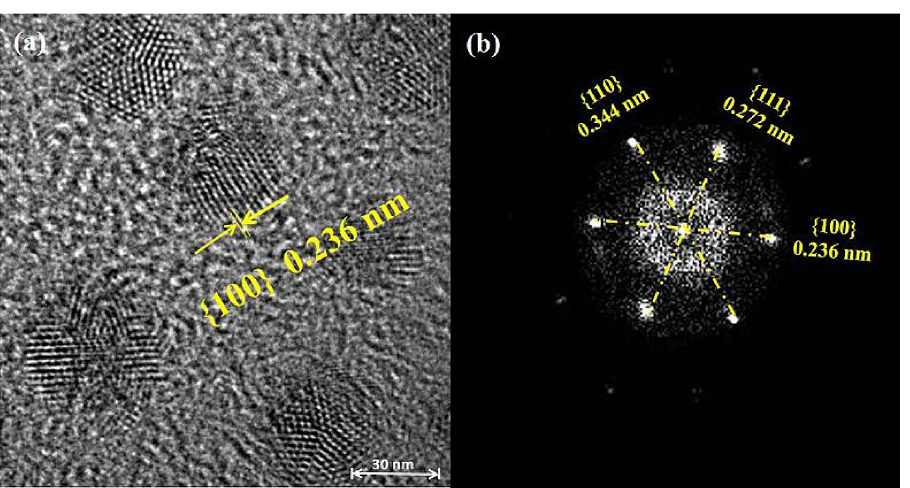
Figure 5. ( a ) HRTEM image of Ag 2 O NPs (60 °C/10 min), ( b ) Corresponding SEAD pattern of Ag 2 O NPs (60 °C/10